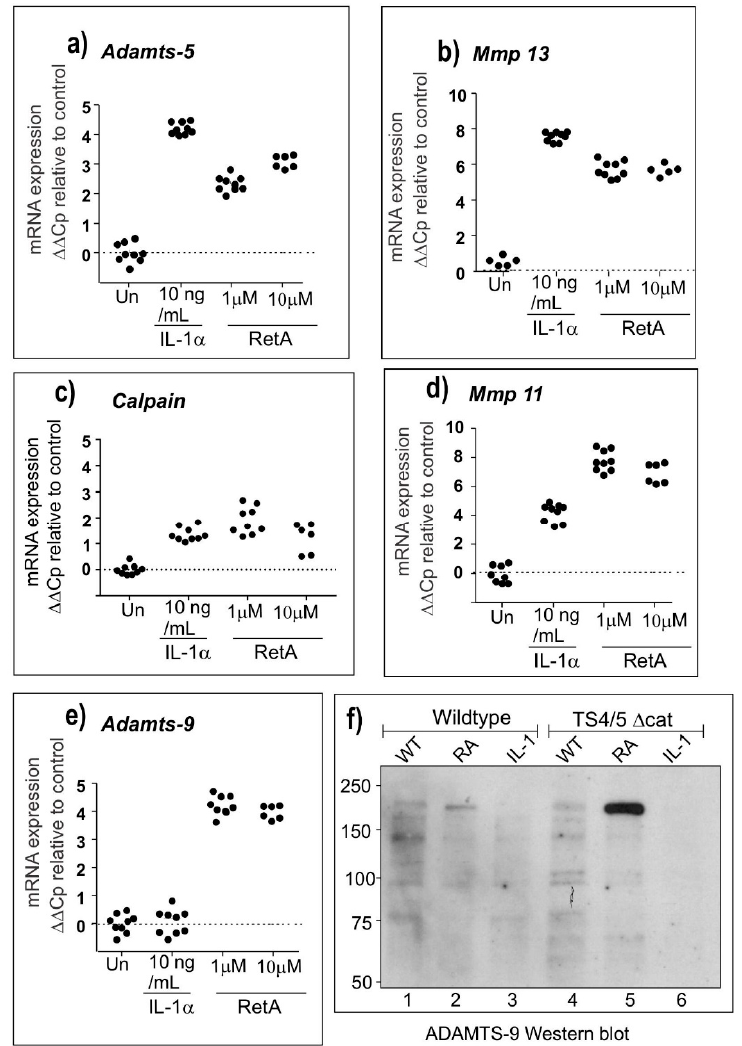
Figure 3. q-PCR and Western blot analyses of candidate aggrecanases. Candidate aggrecanases expressed in cultured cartilage explants were analysed by qPCR for genes including Adamts-5 ( a ), Mmp-13 ( b ), Calpain ( c ), Mmp-11 ( d ), and Adamts-9 ( e ). Protein extracts from Wildtype and TS4/TS5 ∆ cat cartilage extracts were also analysed for ADAMTS-9 expression by Western blotting ( f ).